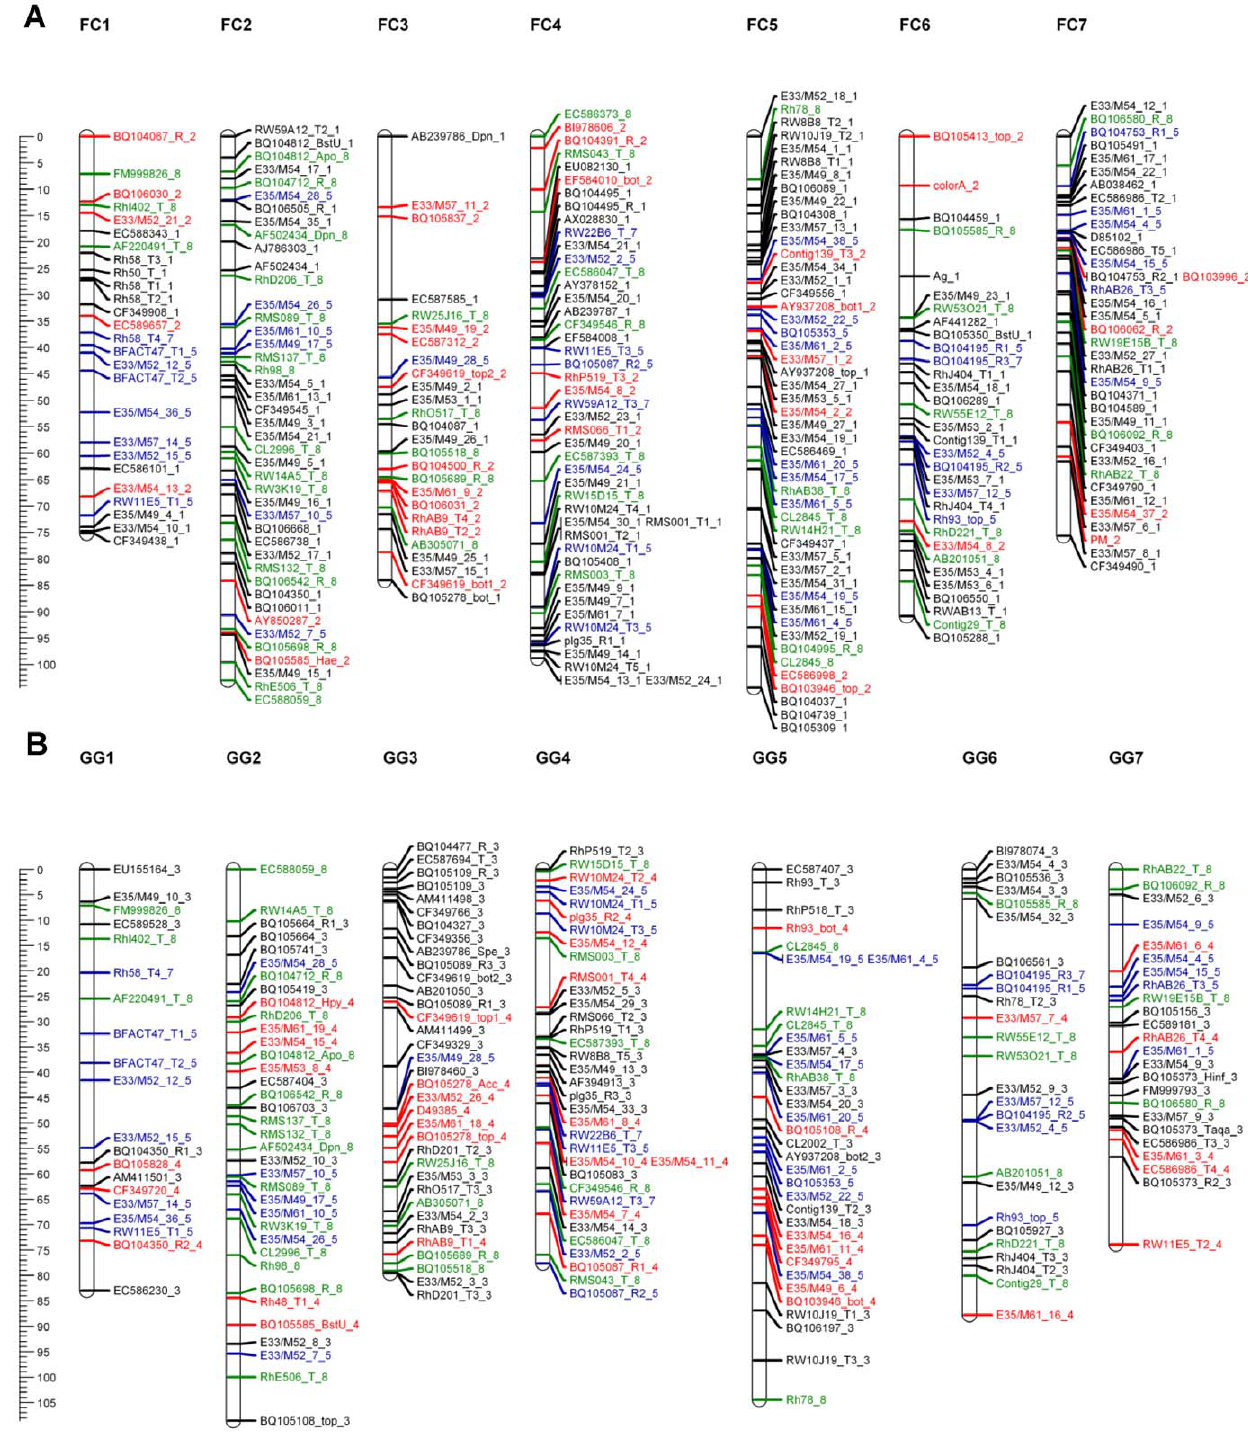
Figure 2. The parental linkage map. Each map consists of seven linkage groups. Map distances are shown in cM as a ruler at the left page margin. Marker names are assigned according to the nomenclature described in Table S1. Each color represents a different segregation ratio (black for 1:1, red for 5:1, blue for 3:1 and green for codominant markers). A . Map of Fragrant Cloud (FC). B . Map of Golden Gate (GG).